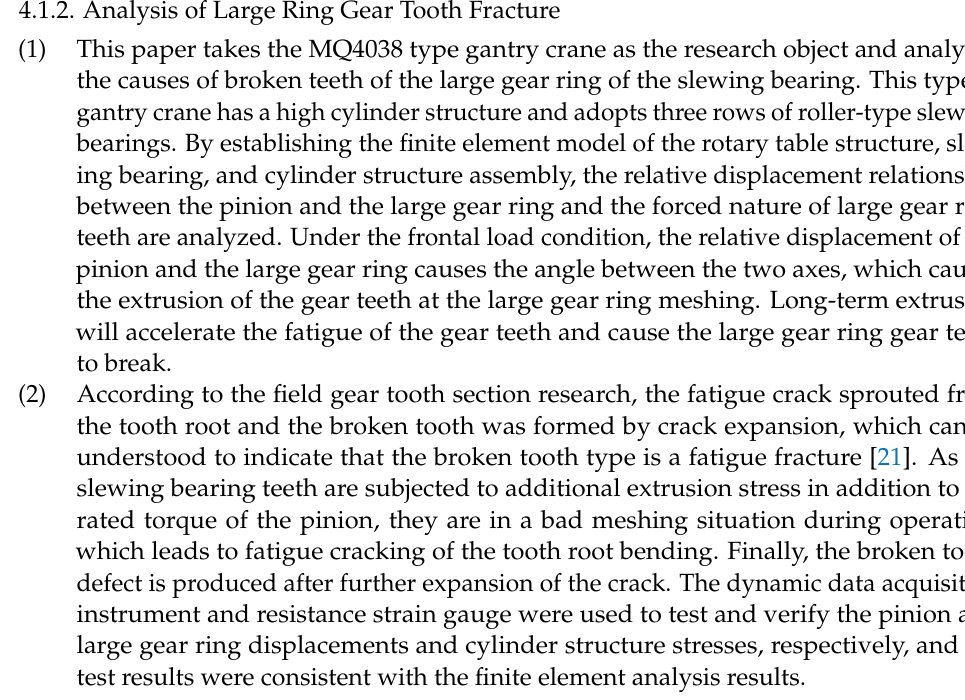
Figure 22. Gear axis non-parallel diagram.